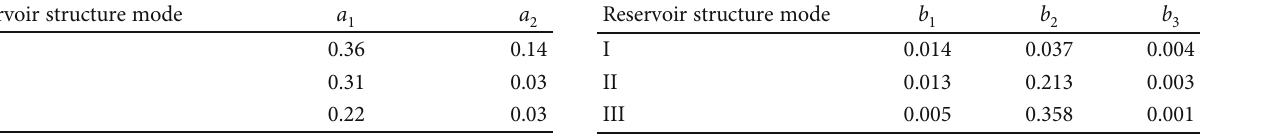
Table 3: The parameters b